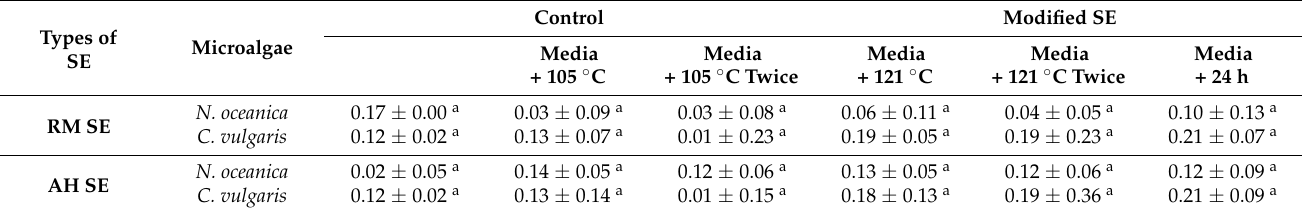
Values shown are mean of three replicates with ± SD. a Mean value in same row with similar superscripts are significantly different ( p < 0.05) using ANOVA and Turkey